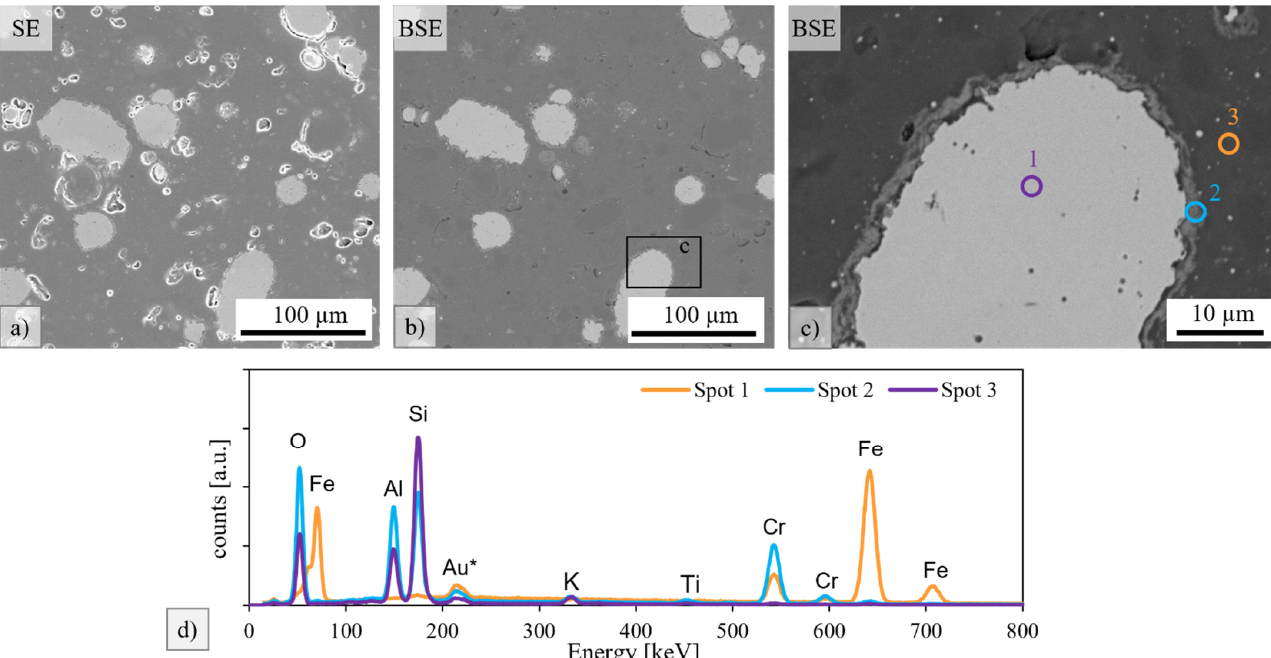
Figure 4. ( a ) Secondary image (SE) and ( b ) backscattered image (BSE) of a clay sample with 50 wt.% 430 L particle additions that was dried and sintered after 3 days. ( c ) Detail of figure ( b ) with marked EDS analysis points. ( d ) EDS results of spots 1 (steel), 2 (seam), and 3 (clay matrix) marked in ( c ).